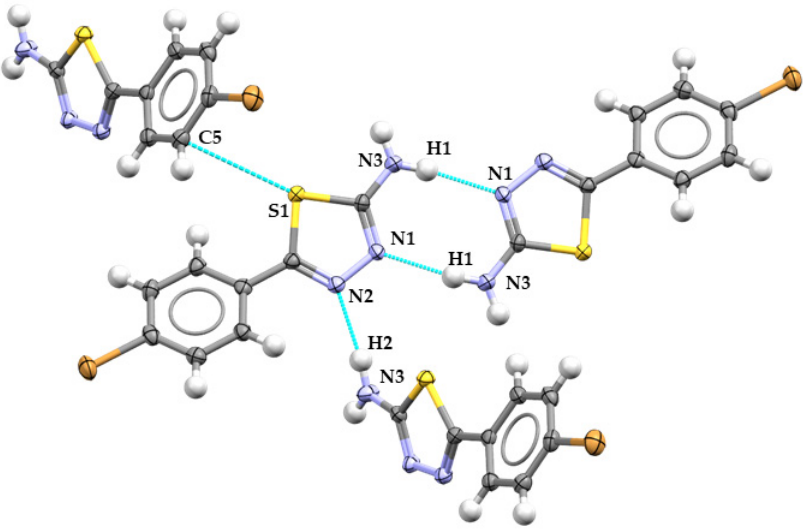
Figure 4. Structure directing interactions in the crystal structure of T1-S-Br [41].